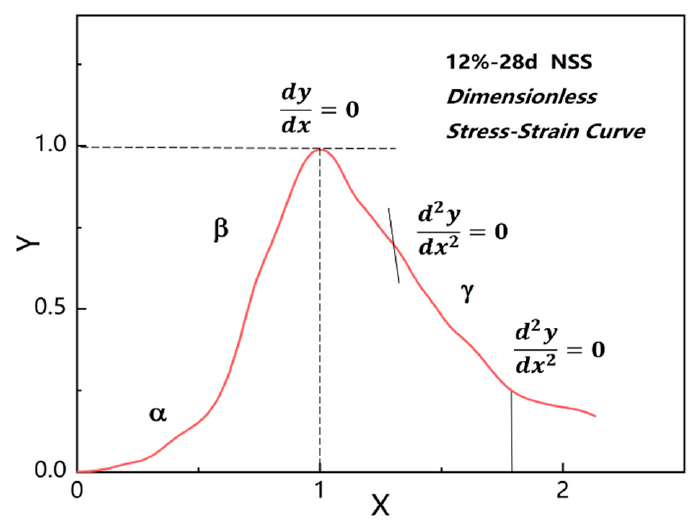
Figure 6. Stress–strain curves after dimensionless processing.